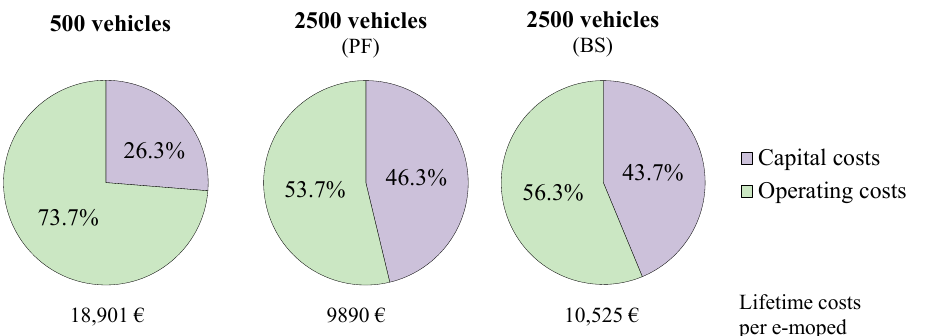
Figure 6. Share of lifetime capital and operative costs of e-moped fleets of additional scenarios (PF—personal factor, BS—8 h battery swap).